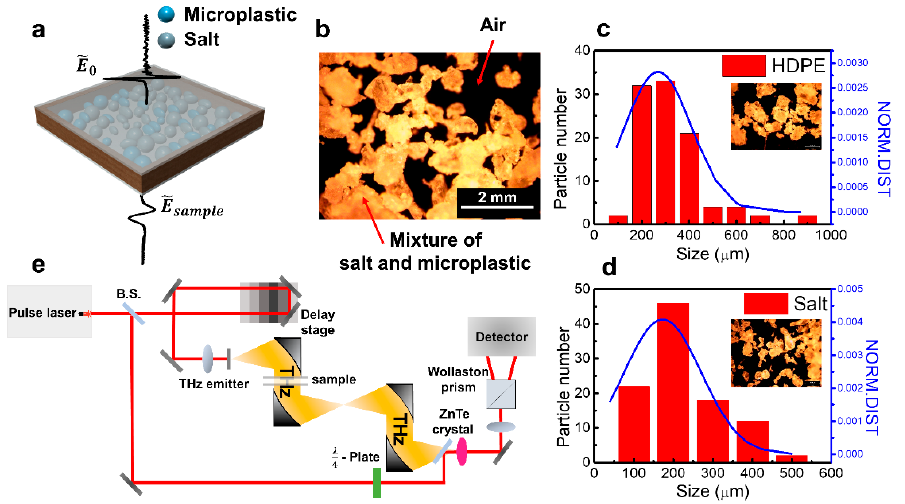
Figure 1. ( a ) An illustration of terahertz transmission measurement for the mixture of salt and microplastic (HDPE). ( b ) A representative optical image of the mixture (salt and HDPE) within the air. ( c , d ) Size distributions of HDPE ( c ) and salts ( d ). ( e ) Schematic of terahertz time-domain spectroscopy set up.